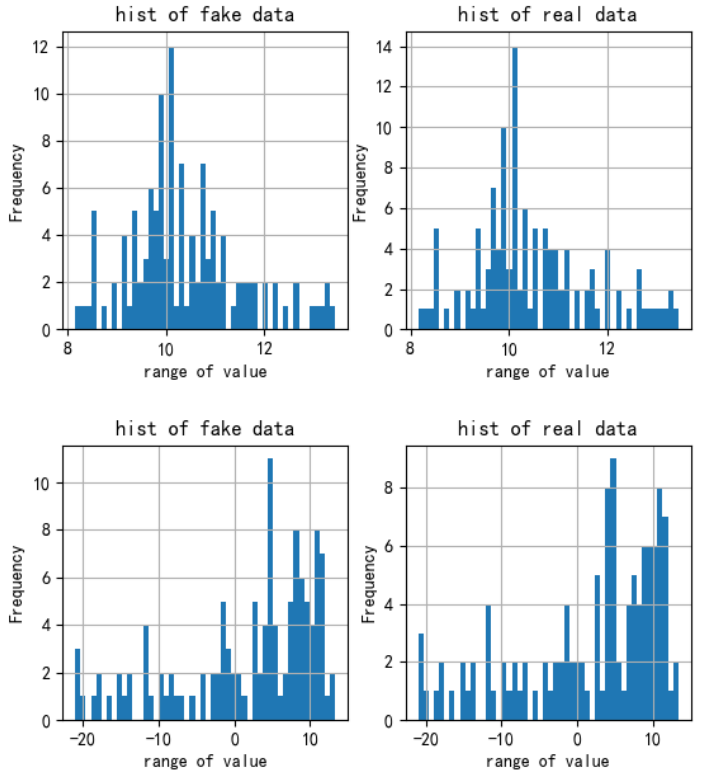
Figure 7. Frequency hist of imputation results and the real time series on ETTh1